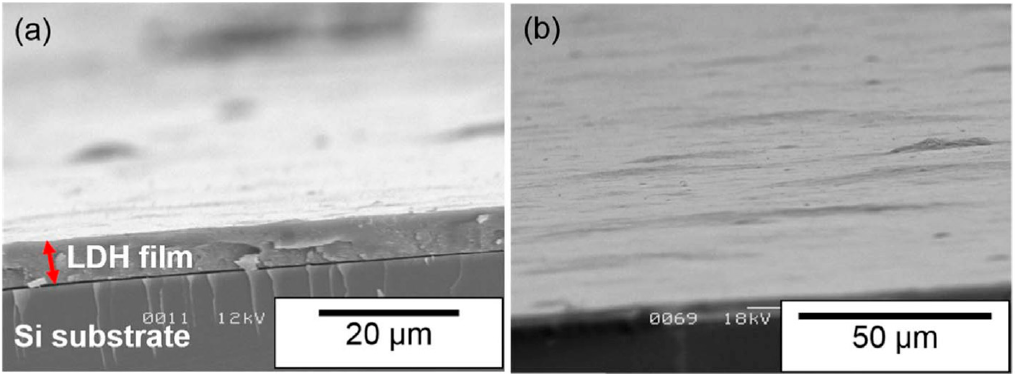
Figure 14. SEM image of the MgAl-acetate LDH film ( a ) at the edge and ( b ) on the surface. Reproduced with permission from reference [145].